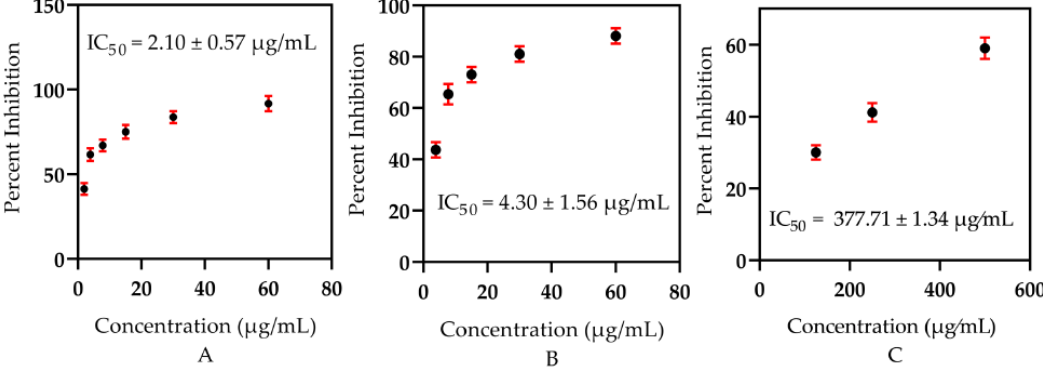
Figure 3. The in vitro antidiabetic significance of B. hirtum essential oils: ( A ) Stem, ( B ) leaves, and ( C ) standard acarbose. ( C ) standard